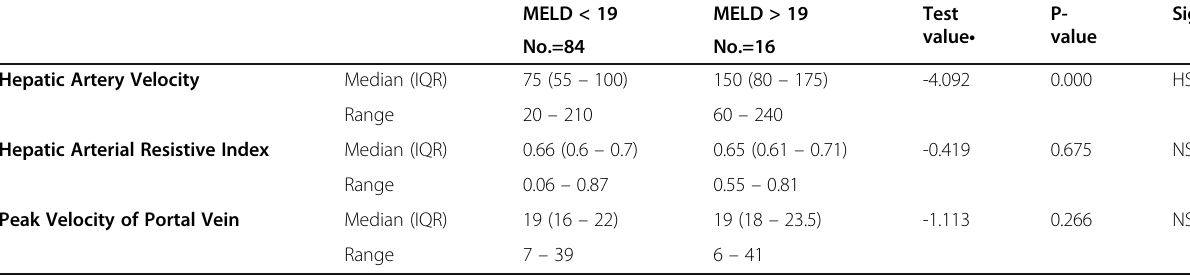
Table 2 Correlation between Doppler ultrasonography findings and MELD score